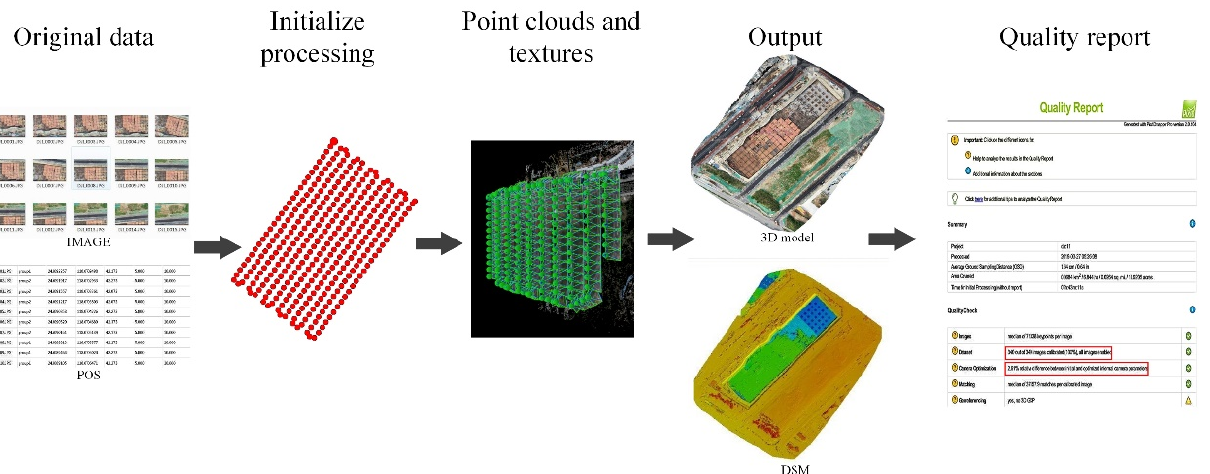
Figure 6. Pix4D mapper UAV image processing flow.